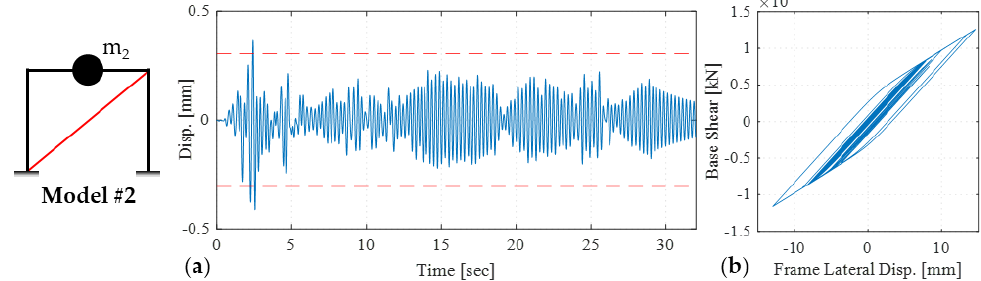
Figure 7. ( a ) Small-scale brace displacement response history along with equivalent brace yield displacement band (red dashed line), and ( b ) global frame force – displacement response for Model #2.